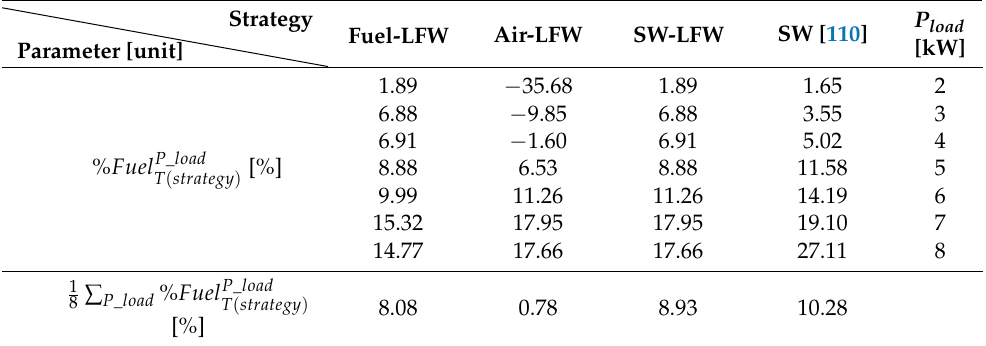
Table 8. Percent of fuel economy for the first load profile in case of k eff = 25 and P ref = 4.5 kW. Strategy Fuel-LFW Parameter [unit]